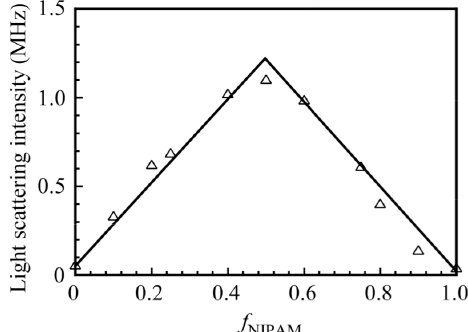
Figure 3. Light scattering intensities of the PNaSS 58 – b – PAA 125 /PNaSS 58 – b – PNIPAM 115 complexes as a function of f NIPAM (= (NIPAM)/((NIPAM)+(AA))) in 0.1 M NaCl at pH 3. The total polymer concentration was fixed at 4.4 g/L.